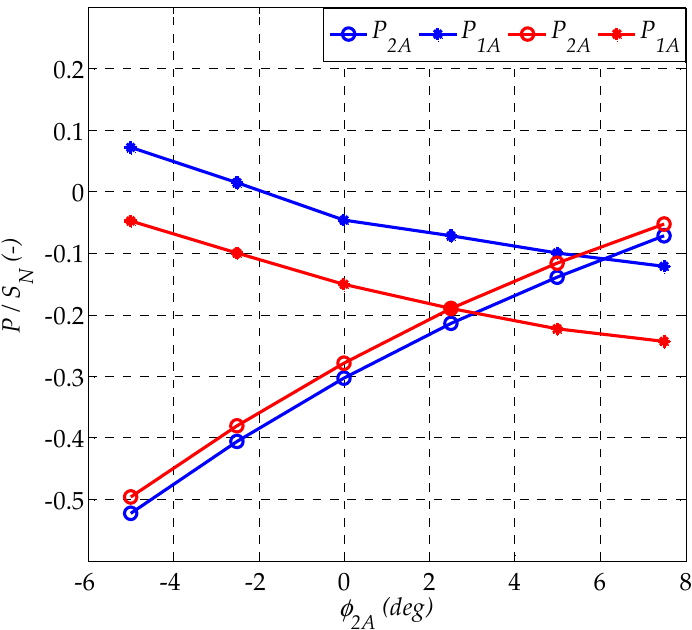
Figure 2. Phase control of active power P 1A and P 2A at U 2A = 1.037·U 2Nphase (blue line — R load, red line — RL load, p.f. = 0.8).